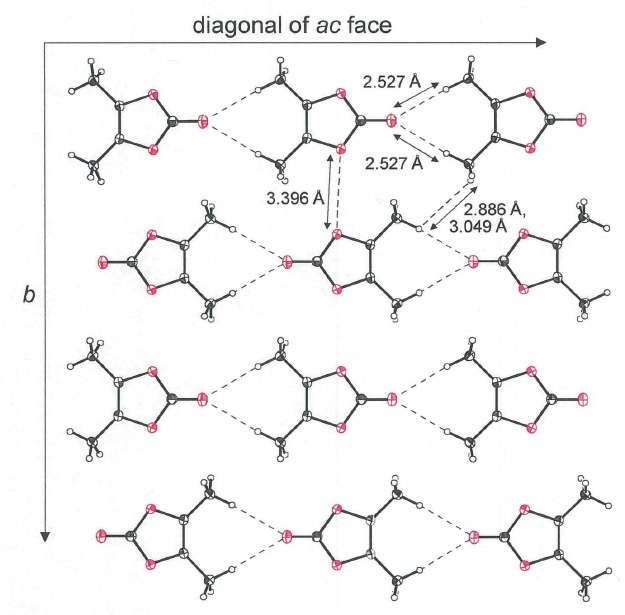
Figure 2 Packing diagram for 4,5-dimethyl-1,3-dioxol-2-one ( 1 ) illustrating the sheetlike arrangement in the plane defined by the b axis and an ac face diagonal. Displacement ellipsoids are at the 50% level, and closest intermolecular contacts are indicated.